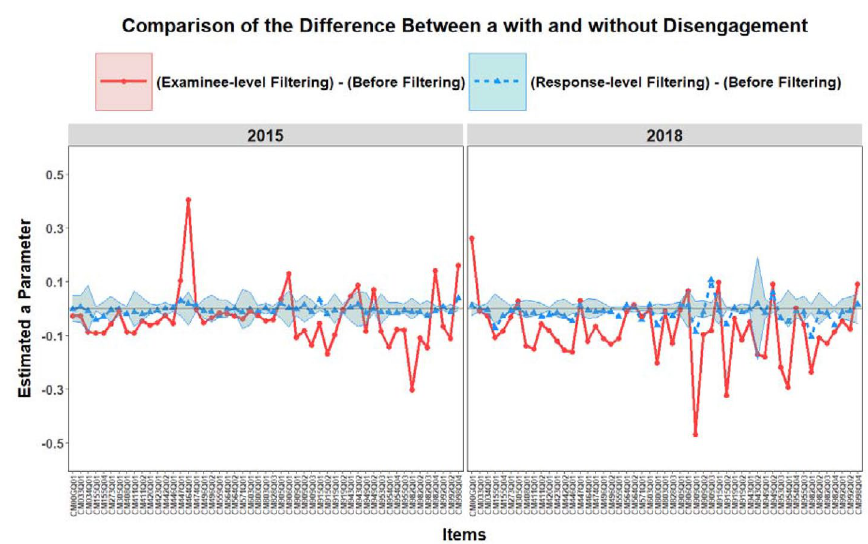
Fig. 6 Comparison of the difference between a with disengagement and without disengagement. The blue line refers to the difference between a with disengagement and after applying response-level filtering; the red line refers to the difference between a with disengagement and after applying examinee-level filtering; and the light green represents the range of the SE of the a parameter estimates with disengagement (i.e., before filtering). Source : Organisation for Economic Co-operation and Development (OECD), Programme for International Student Assessment (PISA), 2015 and 2018 Mathematics